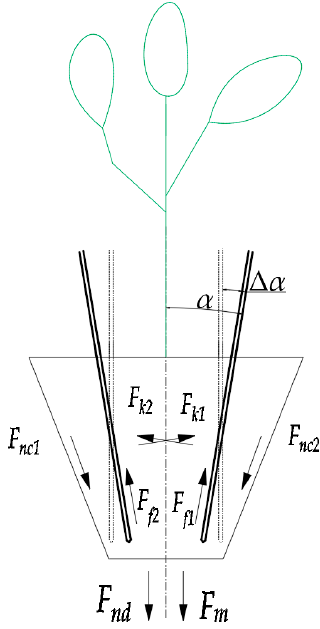
Figure 6. Force analysis diagram of pot.